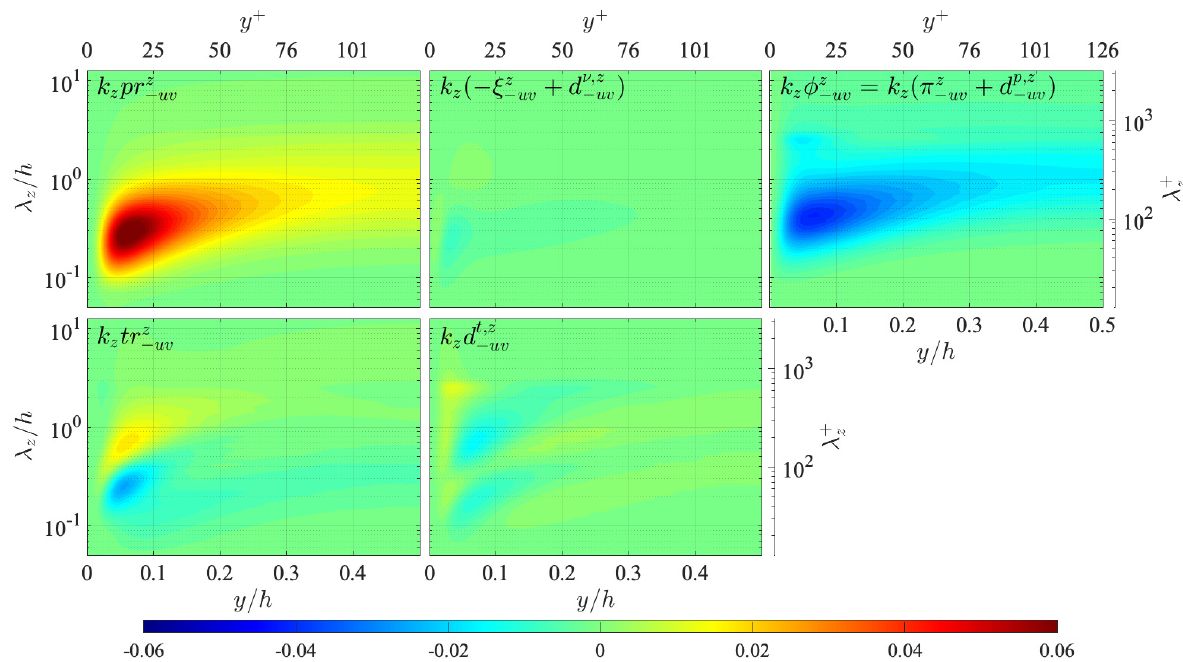
Figure A4. Distribution of terms in the transport equation of the Reynolds shear stress spectrum E z − uv , presented in the same manner as in Figure 12: ( top left ) production pr z − uv ; ( top centre ) viscous terms − ξ z − uv + d ν , z − uv ; ( top right ) pressure term φ z − uv ; ( bottom left ) interscale transport tr z − uv ; (bottom centre) turbulent diffusion d t , z − uv . The terms are presented in the premultiplied form, and the values are scaled by u 4 τ / ν